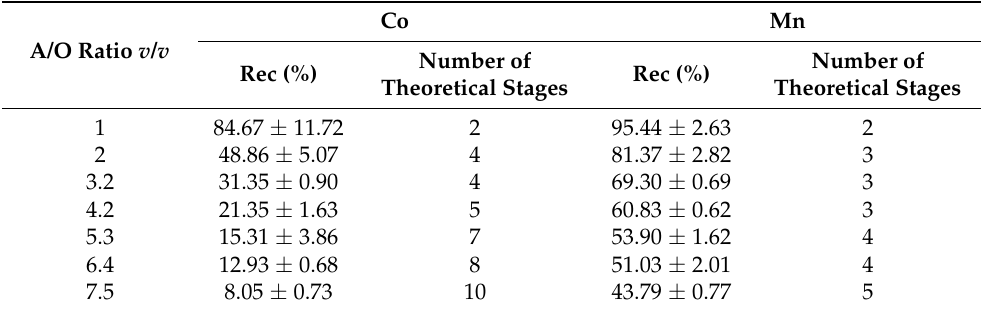
Figure 5. Extraction isotherm of ( a ). Co and ( b ). Mn using Cyanex ® 272 10% v/v , pH 5, McCabe-Thiele plot is shown for A/O ratio 2 (Co) and 4 (Mn). Table 5. Co-Mn extraction rate and theoretical stages required for complete extraction at